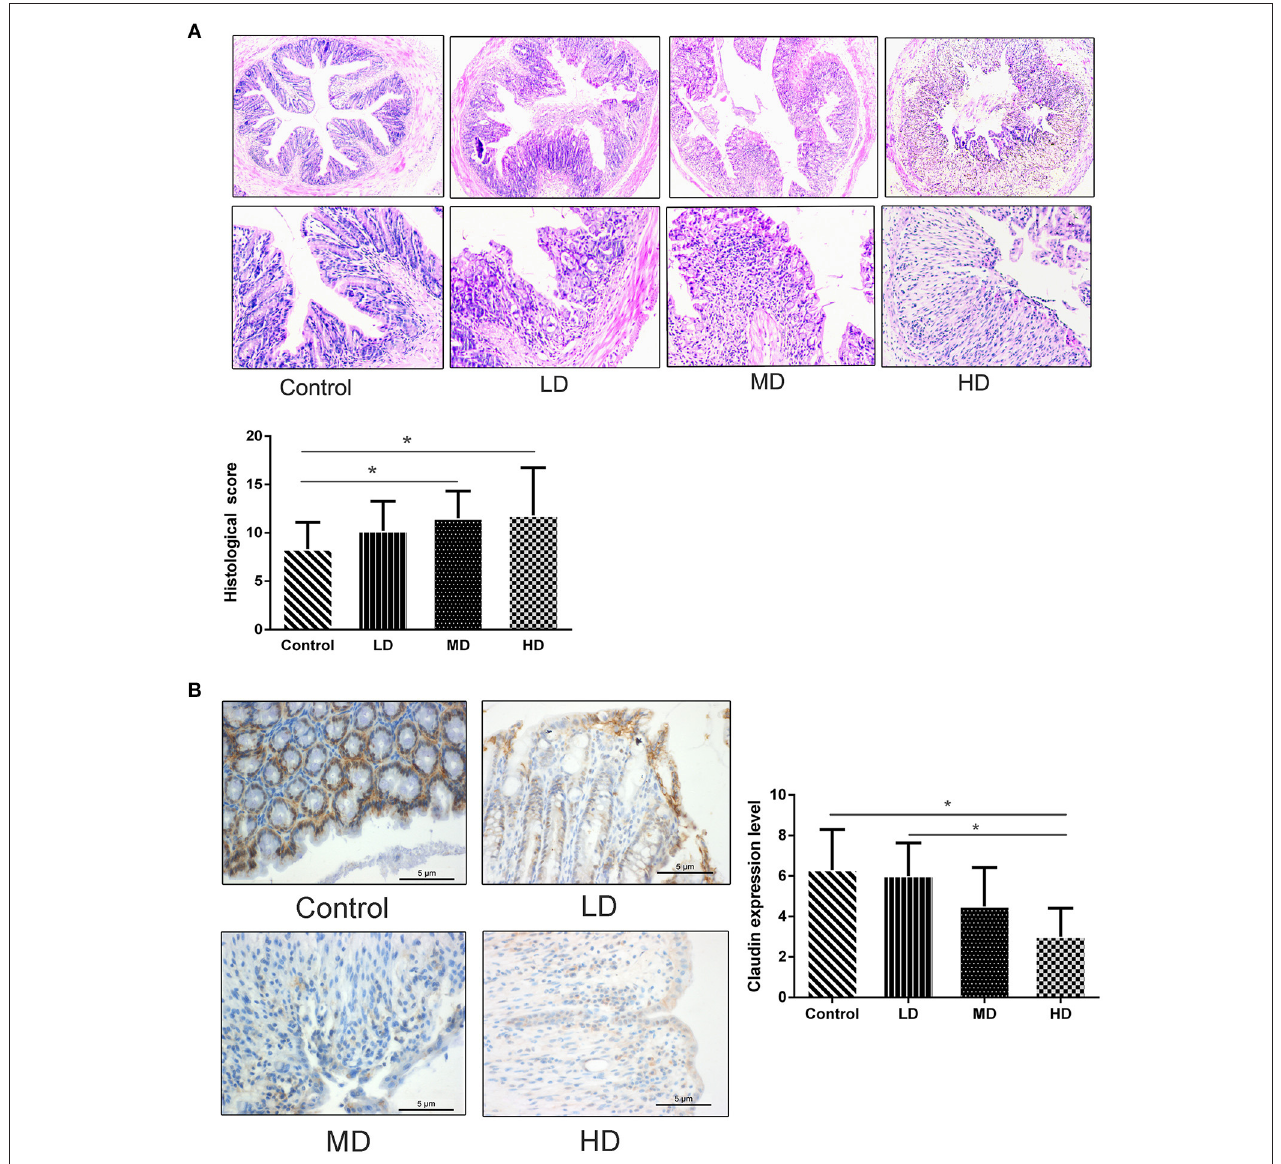
FIGURE 5 | HE staining and immunohistochemical analysis in the colon tissue of DSS colitis. (A) Representative images of HE staining of the colon tissues and histologic injury scored for HE staining in mice fed with various levels of red meat diets. Magnifications: × 100 and × 200. (B) Immunohistochemical analysis of Claudin-1 expression in the colon tissue of mice fed with various levels of red meat diets. Magnifications: × 400. Data are presented as mean ± SD, and * p <